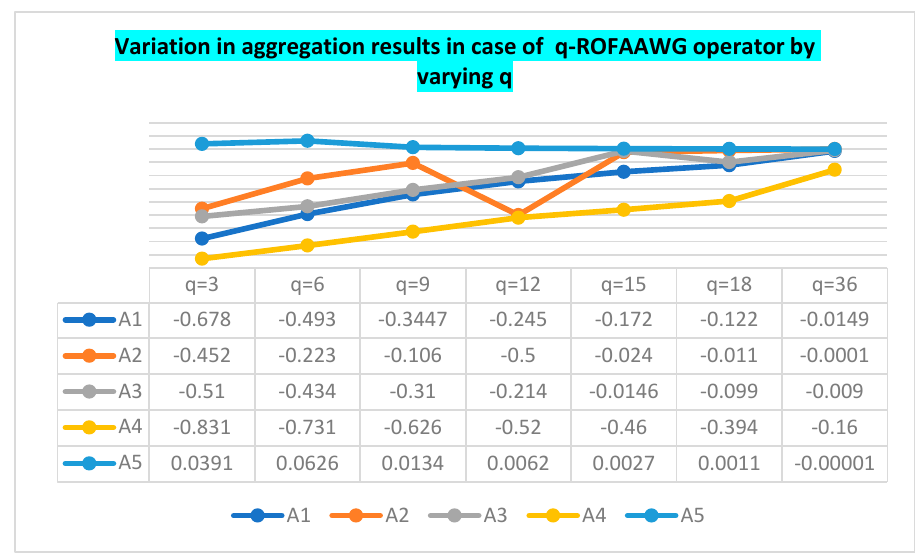
Figure 4. The geometric representation of score value, variation by q. Lines on horizontal lines rep- resent the raking of score values, and here vertical line shows the range of score values of [−1,1] . The geometrical illustration of the ranking order in Table 9 is presented in Figure 5. Here, lines on horizontal lines represent the values of the SF, and vertical lines denote the range of score values of [−1, 1] .